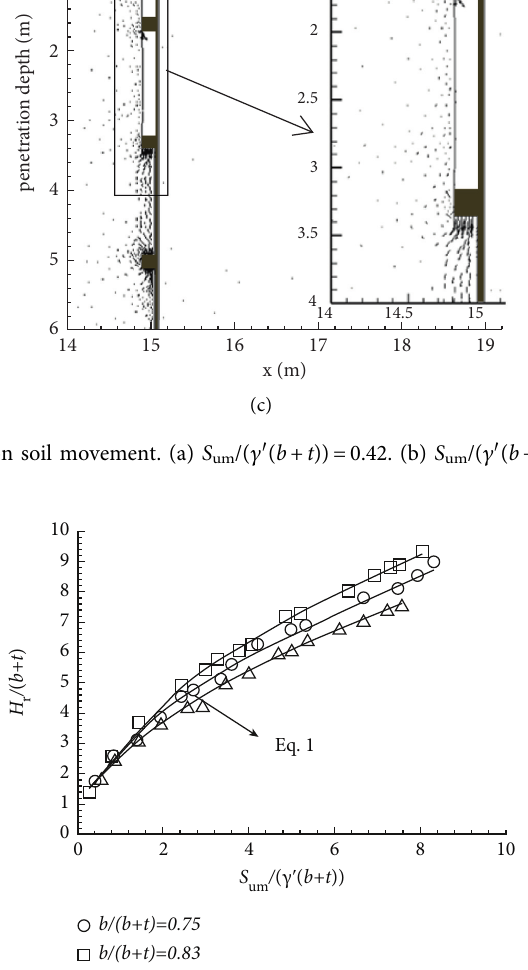
Figure 10: Design chart of the critical depth of rotational soil flow.